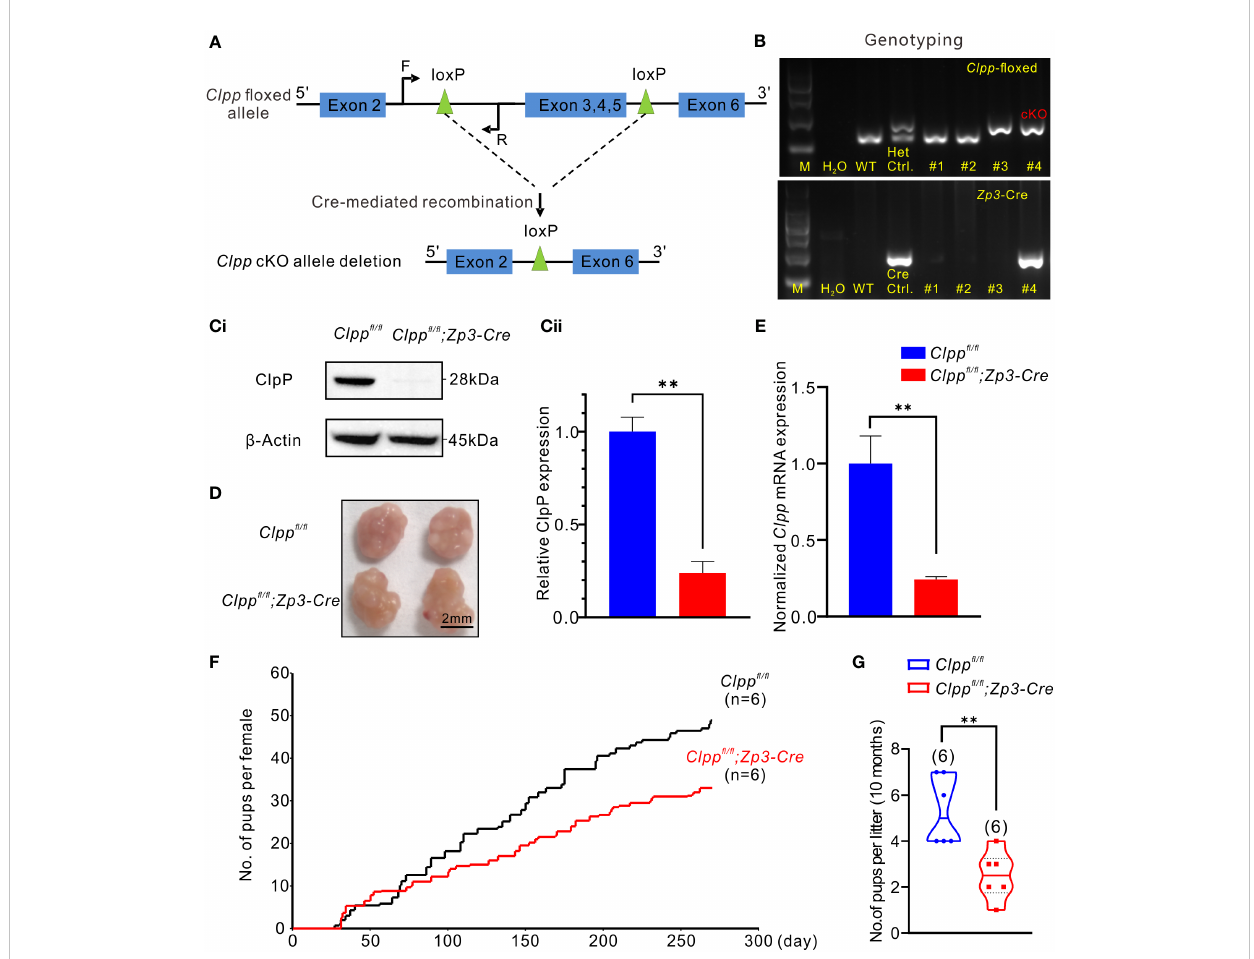
FIGURE 1 Clpp deletion reduced fertility ef fi ciency along with aging. (A) Design of the Cre- LoxP cKO system in the Clpp allele, LoxP sites were inserted on both sides of exon 3/4/5, the two LoxP sites were recombined under the action of CRE protein, and exon 3/4/5 in the two LoxP sites were knocked out. (F=forward primer, R=reverse primer). (B) Genotyping of the Clpp ; Zp3 -Cre cKO mice. Wild-type (WT) mice tail DNA was used as negative control for PCR analysis. Clpp fl /+ (Het.) mice tail DNA was used as a positive control, and a Zp3 -Cre mice tail DNA was used as a positive control for Cre expression. DNA from different mice tail (e.g., #1-#4) was extracted and underwent PCR analysis to check the insertion of LoxP as well as the successful Cre expression. M means marker. (Ci, Cii) Western blotting analysis showed the ClpP protein level at 2-month-old mice in the GV oocytes. b -Actin was used as a loading control. (D) Image of representative ovaries isolated from control and cKO mice (8 weeks old, n=3), The scale bar is 2 mm. (E) RT-PCR analysis showed the Clpp mRNA expression level in GV oocytes. (F) Fertility tests showed the average on accumulated number of pups per female up to 10 months and (G) number of pups per litter in control and cKO groups at 10 months. All the oocyte and ovary samples were from 8-week-old female mice. ** p < 0.01. The results represent mean ± SEM (standard error of the mean). Signi fi cance was determined by Student t